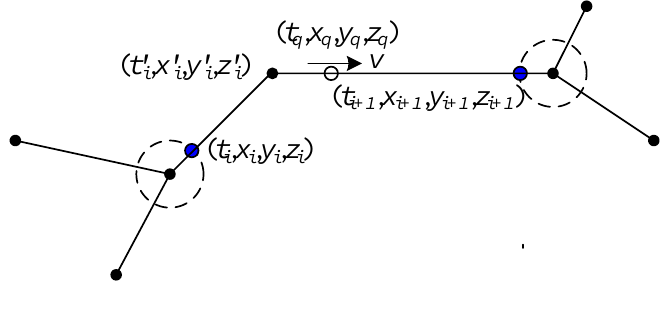
Figure 9. The locations are on the different arcs.